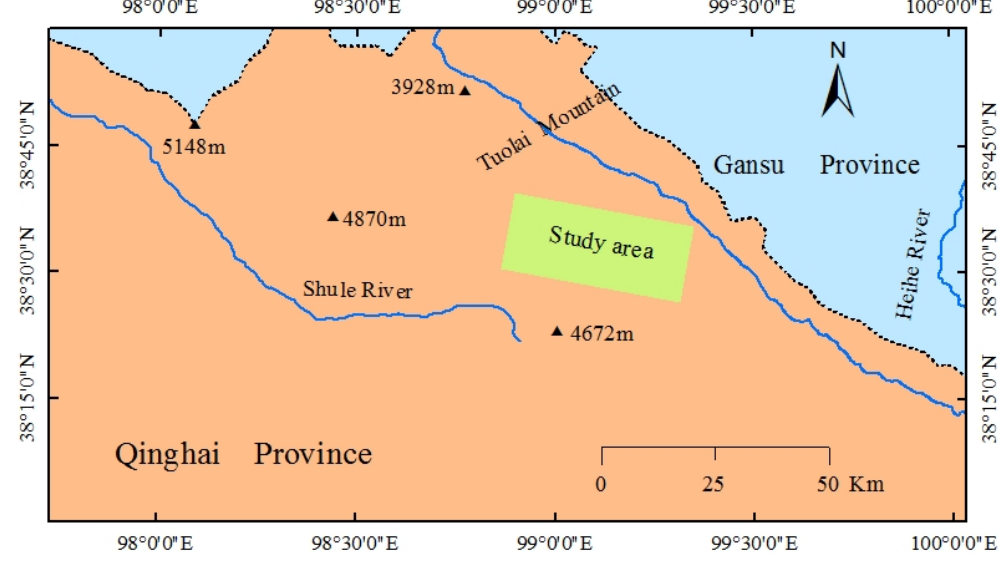
Figure 1. Location of study area.